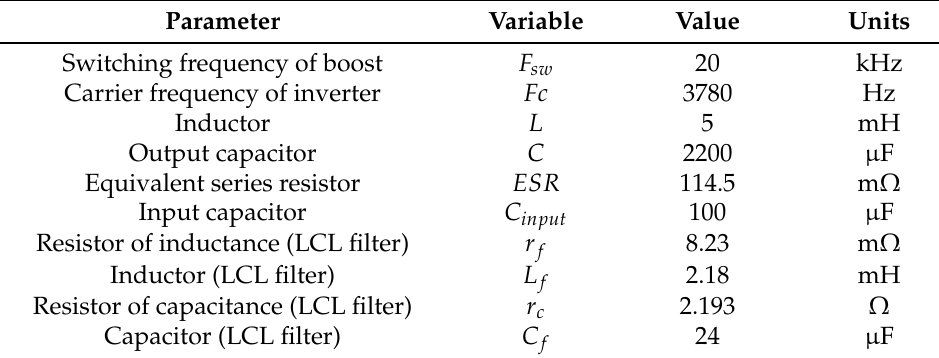
Table 2. Boost converter and inverter